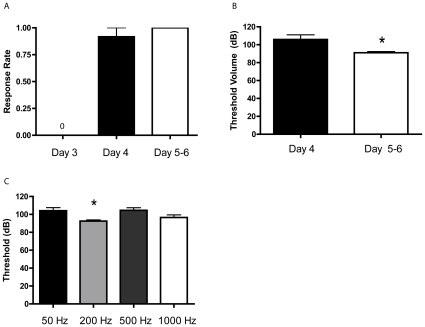
Zebrafish do not exhibit a C-start response to auditory stimuli before 4 dpf, and subsequently are most responsive to a 200-Hz auditory stimulus.(A) Mean response rate of larval zebrafish to AV stimulation during development. No escape responses were elicited 3 dpf (n = 8), whereas the response rate at 4 dpf and 5–6 dpf was 0.92 and 1.0, respectively. (B) Mean volume (dB) of auditory pulses that elicit a C-start response in larvae 4 dpf (n = 12) and 5–6 dpf (n = 8). It required significantly stronger auditory stimulation to evoke a C-start in the younger fish than in the older fish (t
[18] = 2.28, p<0.05). One 4 dpf zebrafish failed to respond to auditory pulses, and therefore were assigned a threshold of 135 dB, the highest volume tested. (Data in Figures 2A and 2B are from the same experiments.) The asterisk indicates a significant difference between the groups. Error bars in this and subsequent graphs represent SEM. (C) Mean volume (dB) of sound pulses of different auditory frequencies used to elicit a C-start reflex: 50 Hz (n = 8), 200 Hz (n = 8), 500 Hz (n = 8), and 1000 Hz (n = 8). A one-way ANOVA performed on the group data was significant (F
[3,28] = 4.58, p<0.01). The mean threshold to elicit escape responses was 104.13±3.38 dB in the 50 Hz group, 92.5±1.32 dB in the 200 Hz group, 104.5±2.93 dB in the 500 Hz group, and 96.5±2.93 dB in the 1000 Hz group. SNK post hoc tests showed that a 200 Hz stimulus elicited escape responses at a significantly lower threshold than did either the 50 Hz stimulus or the 500 Hz stimulus (p<0.05), as indicated by the asterisk.